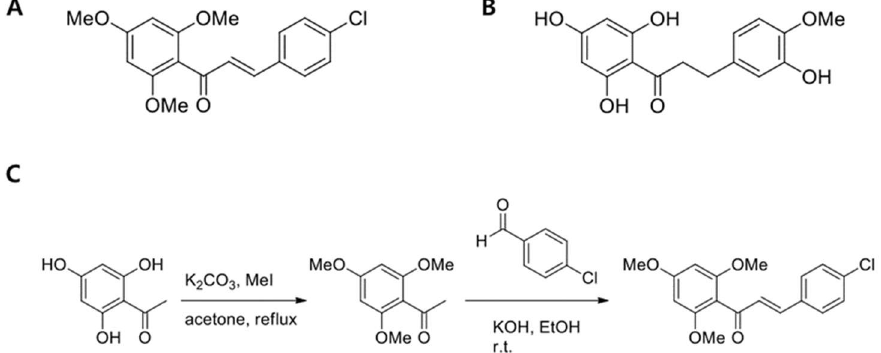
Figure 1. Structures of ( E )-3-(4-chlorophenyl)-1-(2,4,6-trimethoxyphenyl)prop-2-en-1-one (CTP) ( A ) and neohesperidin dihydrochalcone (NHDC) aglycone ( B ) and a synthetic scheme of CTP ( C ).